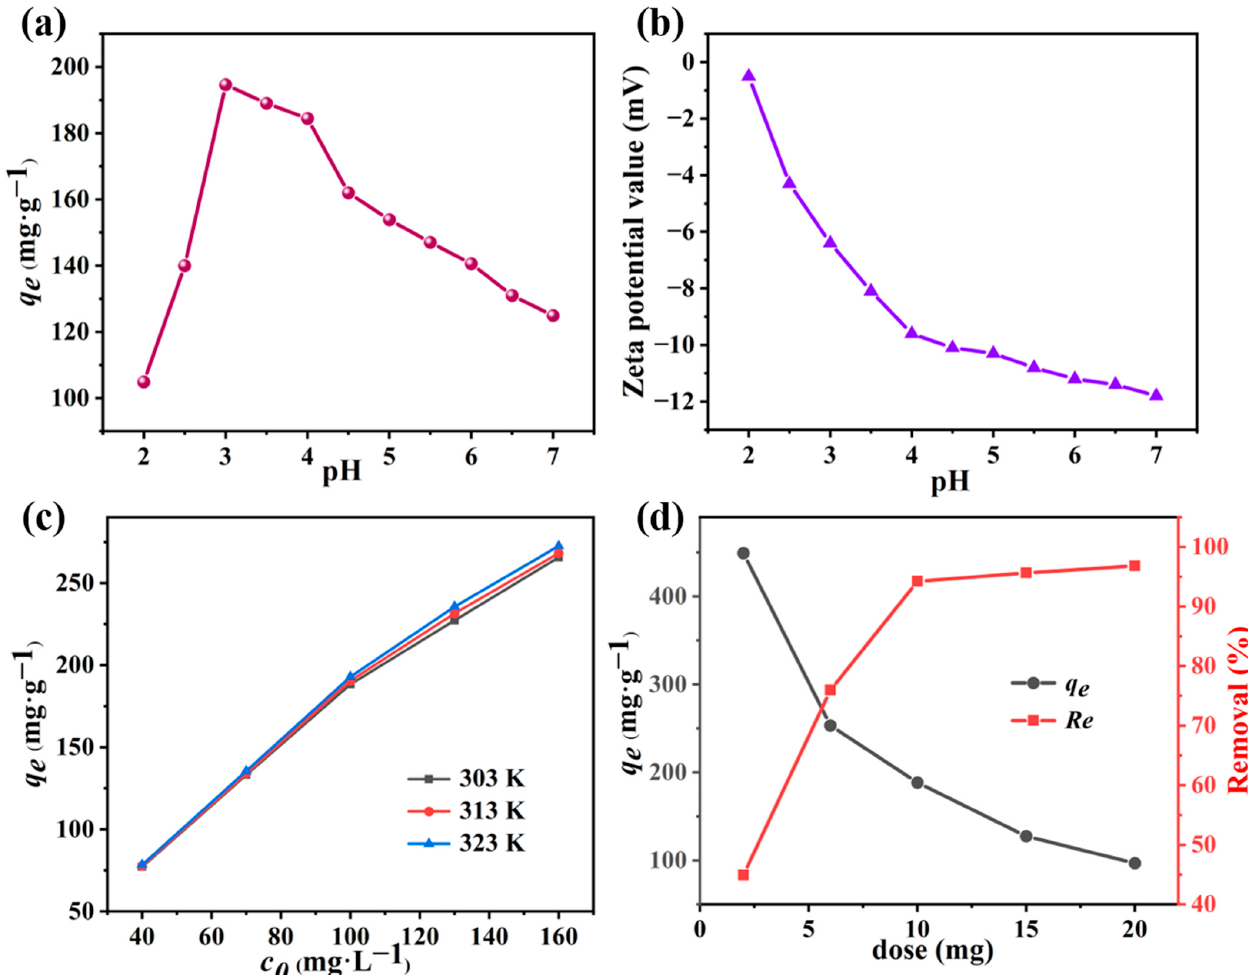
Figure 6. ( a ) The influence of pH on adsorption effect; ( b ) Zeta potential diagram. The influence of initial concentration ( c ) and dose ( d ) on adsorption effect.